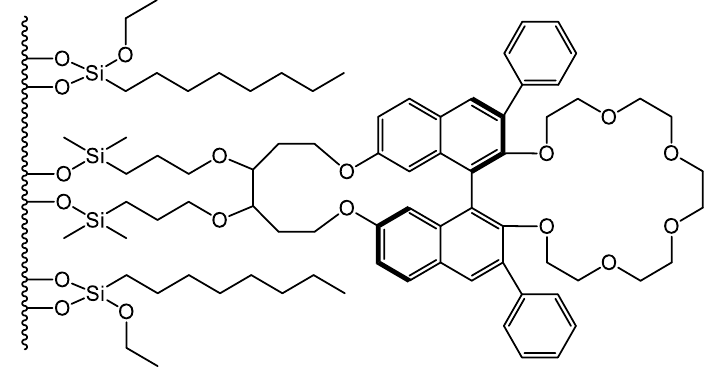
Figure 5. Structure of CSP applied in Ref.